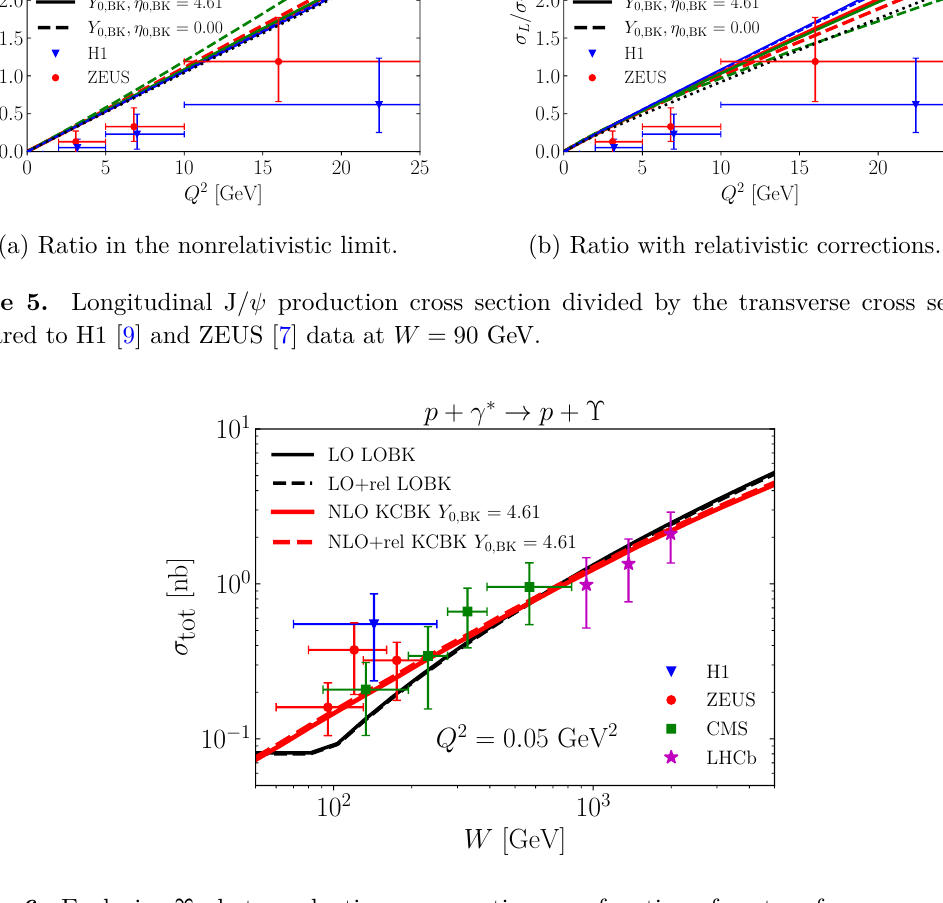
Figure 6. Exclusive Υ photoproduction cross section as a function of center-of-mass energy W compared with HERA [119–121] and LHC [122, 123] data. Results are obtained using the KCBK evolution equation with initial evolution rapidity Y 0 , BK = 4 . 61